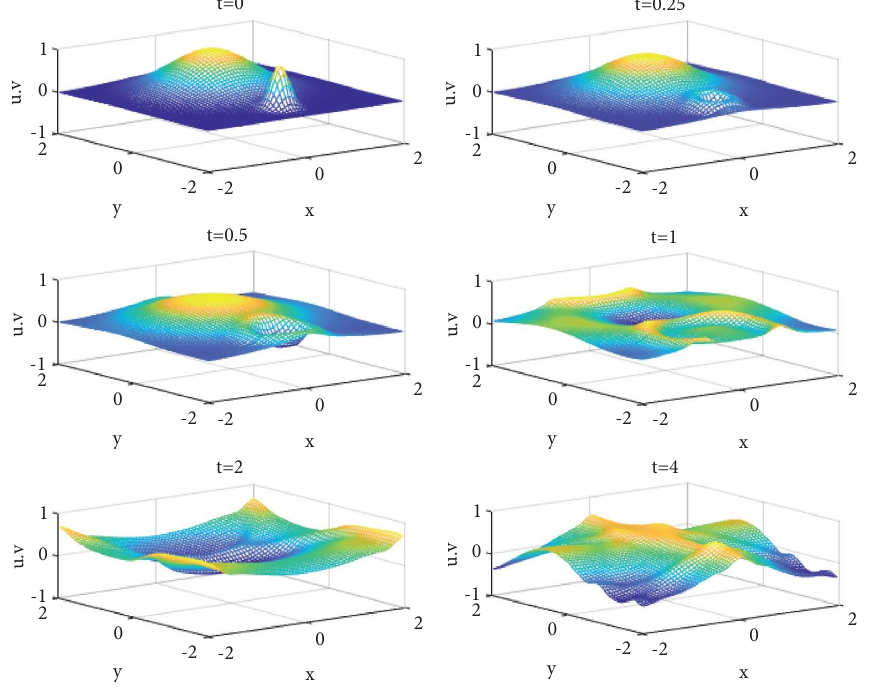
Figure 1: The variation trend of